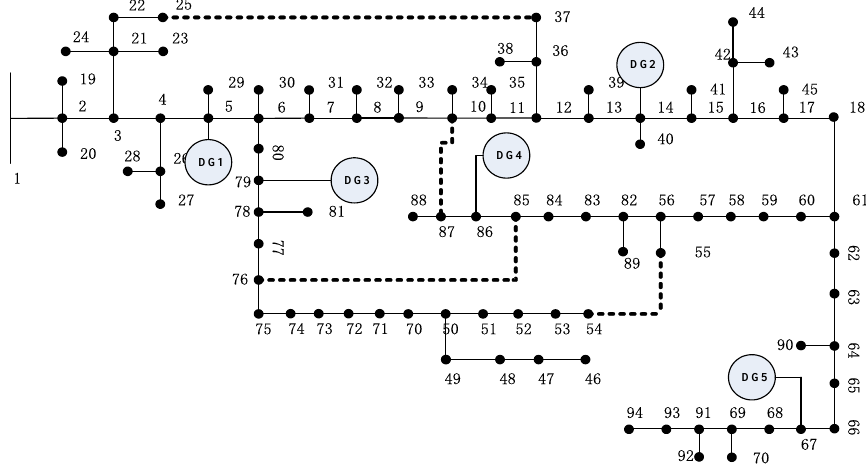
Figure 2. Concrete structure of the actual distribution network. 332